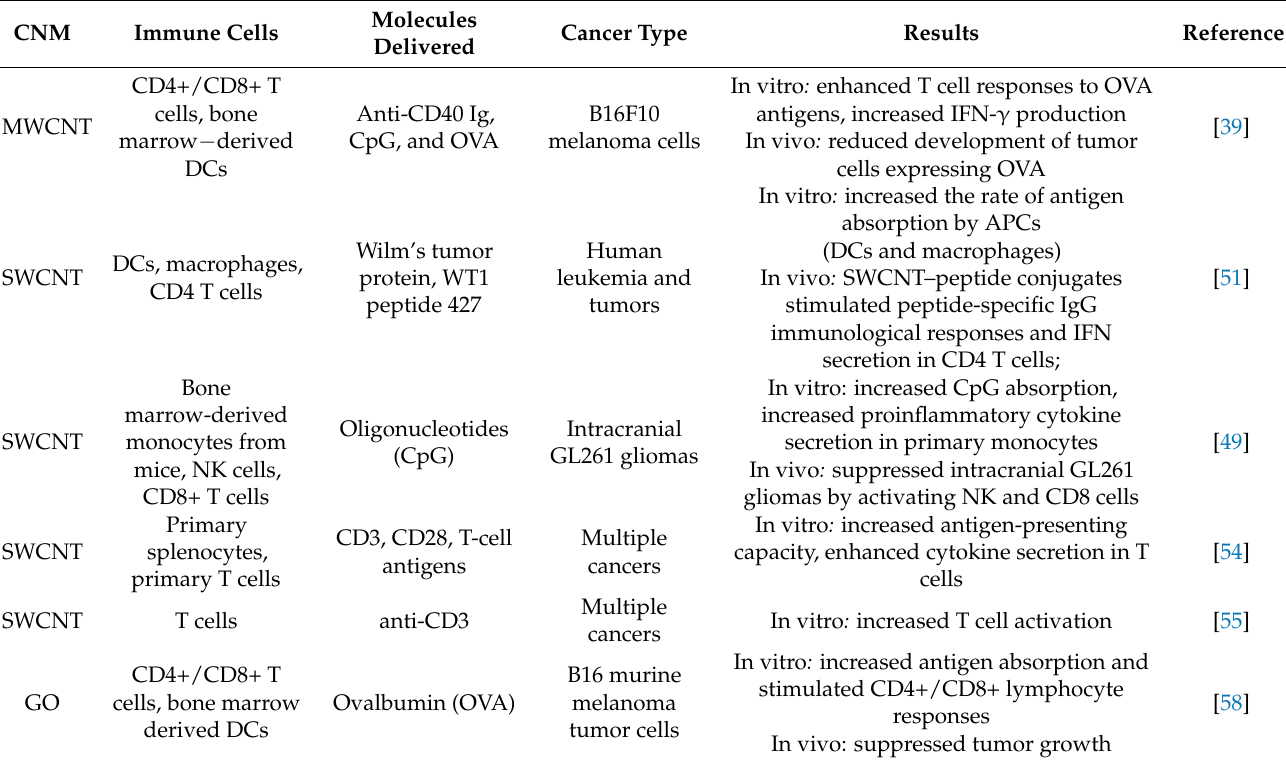
Table 2. Immunomodulation of CNMs in preclinical cancer